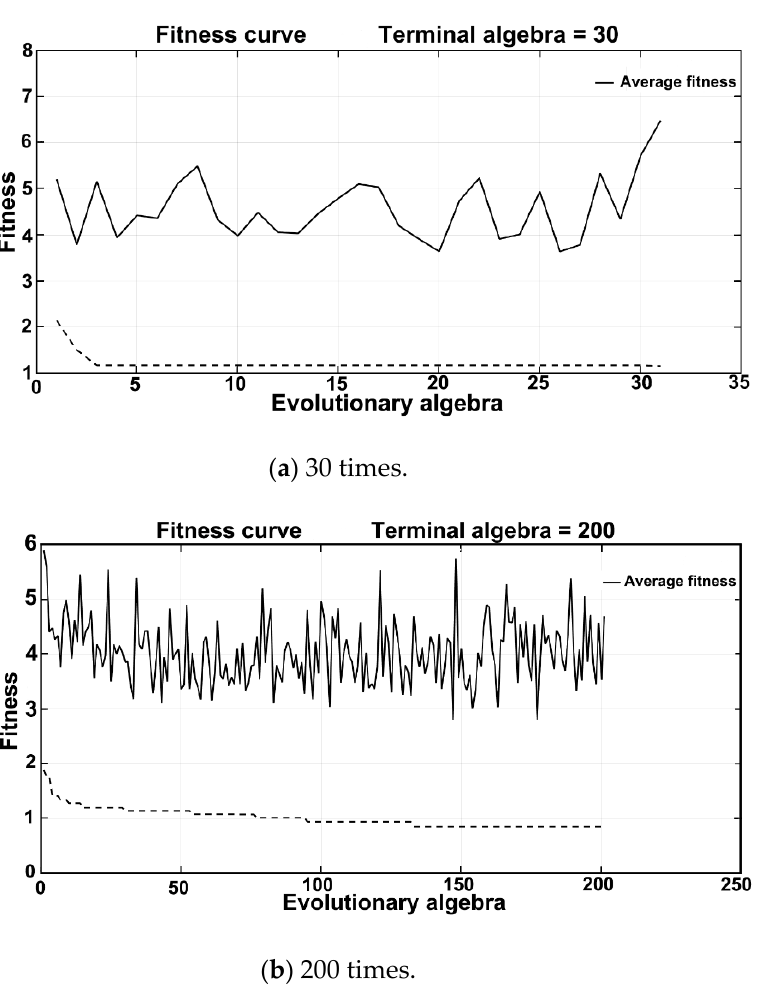
Figure 7. Fitness curve of the GA of the monitoring model.